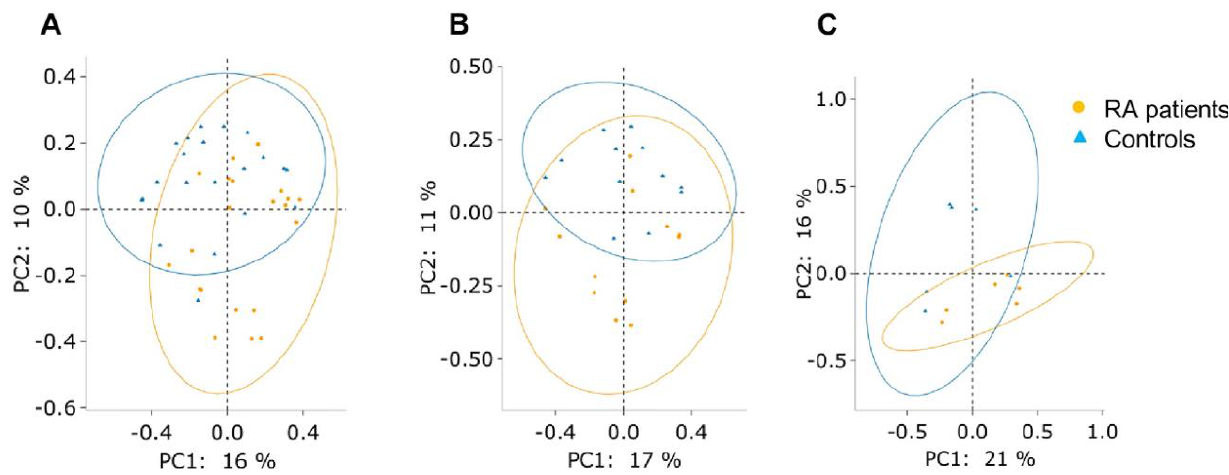
Figure 3. The subgingival microbiota clustering by PCoA based on Bray–Curtis dissimilarity between the RA patients (orange dots) and controls (blue triangles). ( A ) Group AM (ANOSIM: R = 0.177, p = 0.001 and PERMANOVA: pseudo-F = 2.561, p = 0.001), ( B ) group PD (ANOSIM: R = 0.15, p = 0.013 and PERMANOVA: pseudo-F = 1.722, p = 0.018), and ( C ) group PH (ANOSIM: R = 0.167, p = 0.116 and PERMANOVA: pseudo-F = 1.449, p = 0.076).